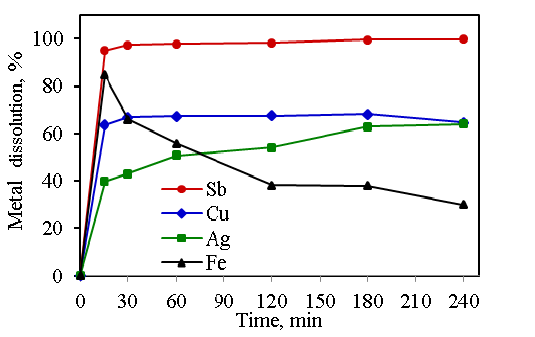
Fig. 3. Effect of leaching time on metals (Sb, Cu, Ag, Fe) dissolution